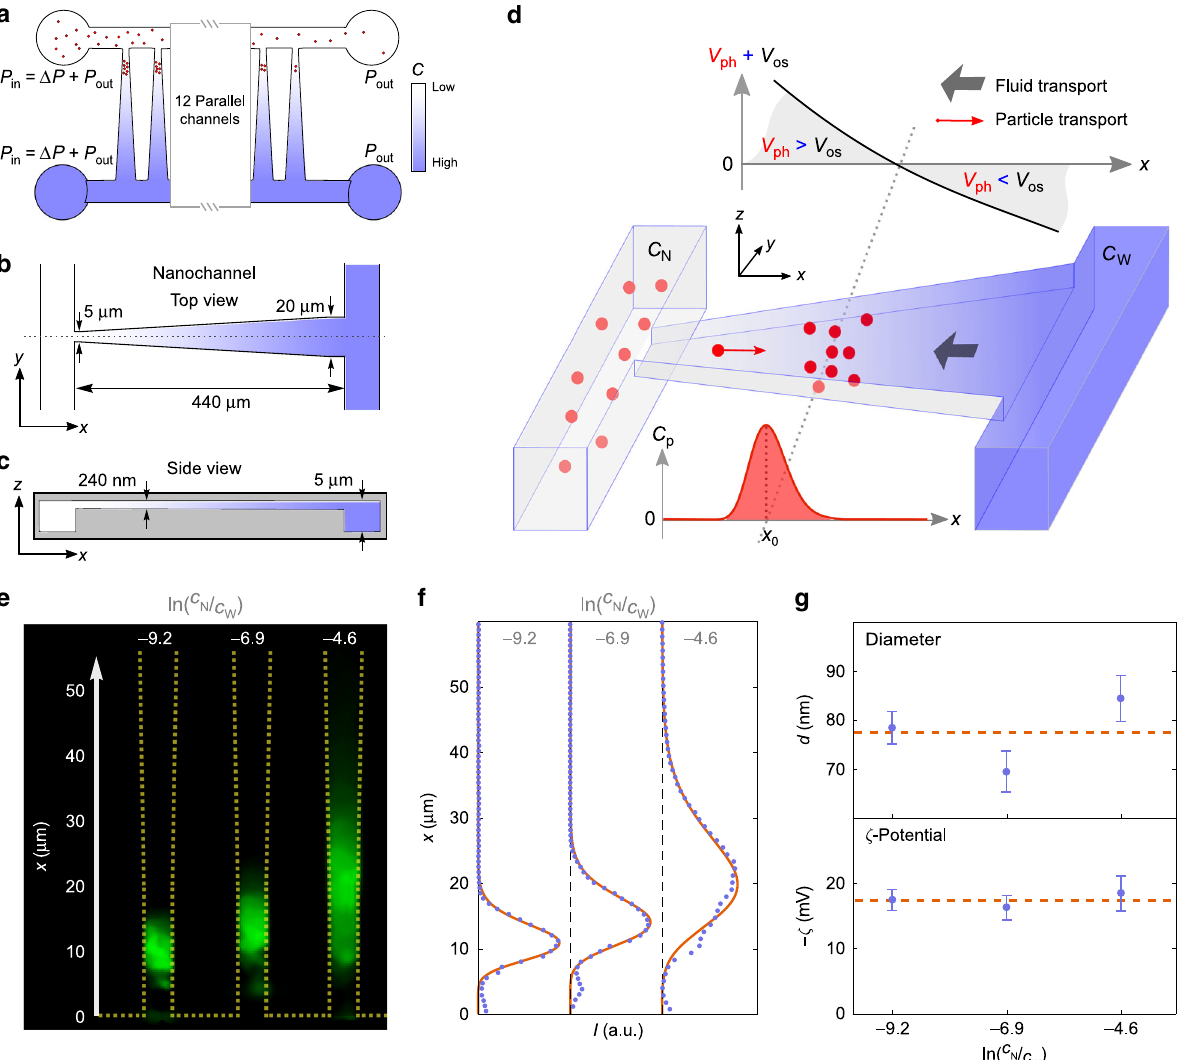
Fig. 1 Trapping of nanoparticles in a salinity gradient. a Schematic of the nano fl uidic device with 16 funnel-shaped, parallel nanochannels connecting two microchannels. Pressure differences Δ P between the in- and outlets continuously drive buffers through the microchannels. Different salt concentrations C N and C W in the two microchannels at the narrow and wide ends of the nanochannels, respectively, establish a salt gradient across the nanochannels. Nanoparticles (red dots) are loaded in the microchannel with low salinity and some get trapped in the nanochannels. b , c Schematic top and side view of the funnel-shaped nanochannels, respectively. d Schematic of nanoparticle trapping in a funnel-shaped nanochannel by diffusioosmosis and diffusiophoresis. The gradient induces a diffusioosmotic fl uid fl ow velocity ν os and a diffusiophoretic particle velocity ν ph . Nanoparticles (red dots) get trapped around the position x 0 where the fl uid and particle velocities balance each other. The concentration of nanoparticles in the nanochannel is denoted C x ). e Composite fl uorescence microscope image of trapped exosomes in the same nanochannel (outlined with yellow) for three different salinity p ( gradients, that is, different ln( C N / C W ) values. Images were averaged over 10 s. f Fluorescence intensity along the nanochannels for the data shown in e (blue points). Full, red lines are independent fi ts to C p ( x ) in Eq. (7). Fit parameters are the diameter d and the zeta potential ζ . g Exosome diameters and zeta potentials from fi ts shown in f . Red, dotted lines are the weighted averages. Error bars are the standard errors on the means for measurements in three different nanochannels ( n =